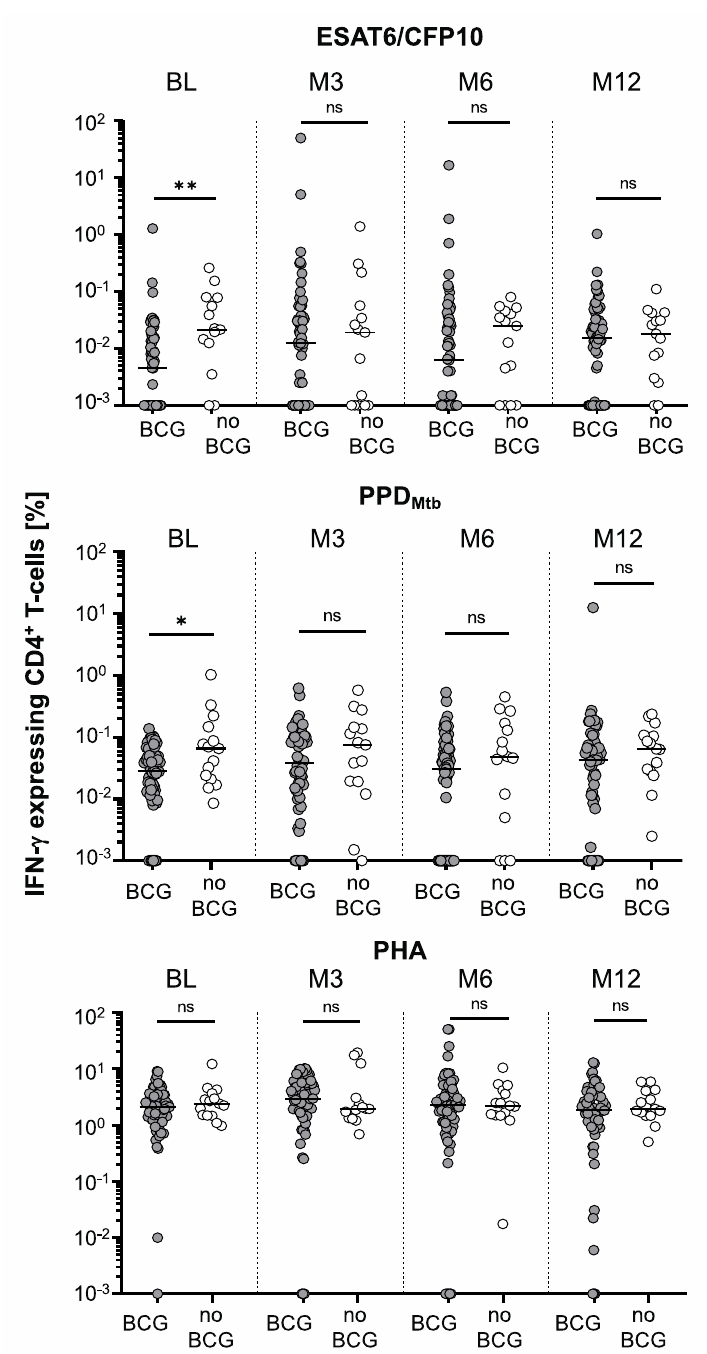
Figure 2. Comparison of M. tuberculosis -specific IFN- γ -positive CD4 + T-cell proportions between BCG-vaccinated and non-BCG-vaccinated children at BL and follow-up timepoints. Proportions of IFN- γ -positive CD4 + T-cells stimulated with M. tuberculosis antigens ESAT6/CFP10, PPD Mtb , or PHA are shown as symbol plots. Each circle indicates mean values of duplicate measurements for individual contacts with BCG vaccination (dark gray circles, n = 64) or without (open circles, n = 15). Solid lines indicate the median values for individual groups and timepoints. The Mann–Whitney U-test was applied and a p < 0.05 was considered statistically significant. Asterisks indicate significant differences (* for p < 0.05, ** for p < 0.01). ns, non-signi fi cant.